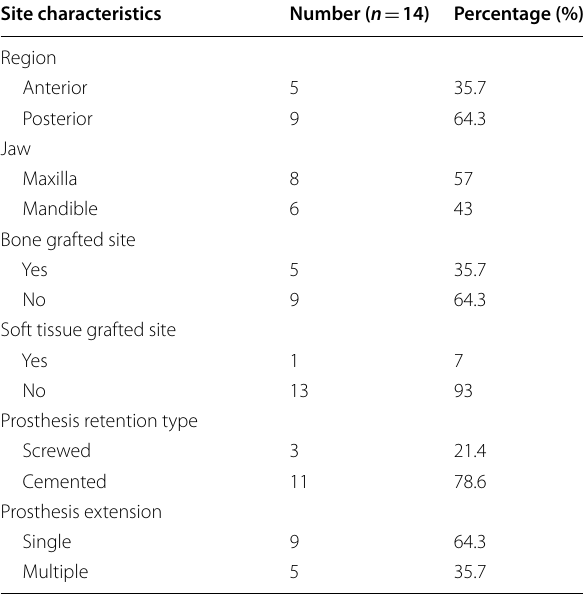
Table 1 Description of implant site characteristics and frequency distributions